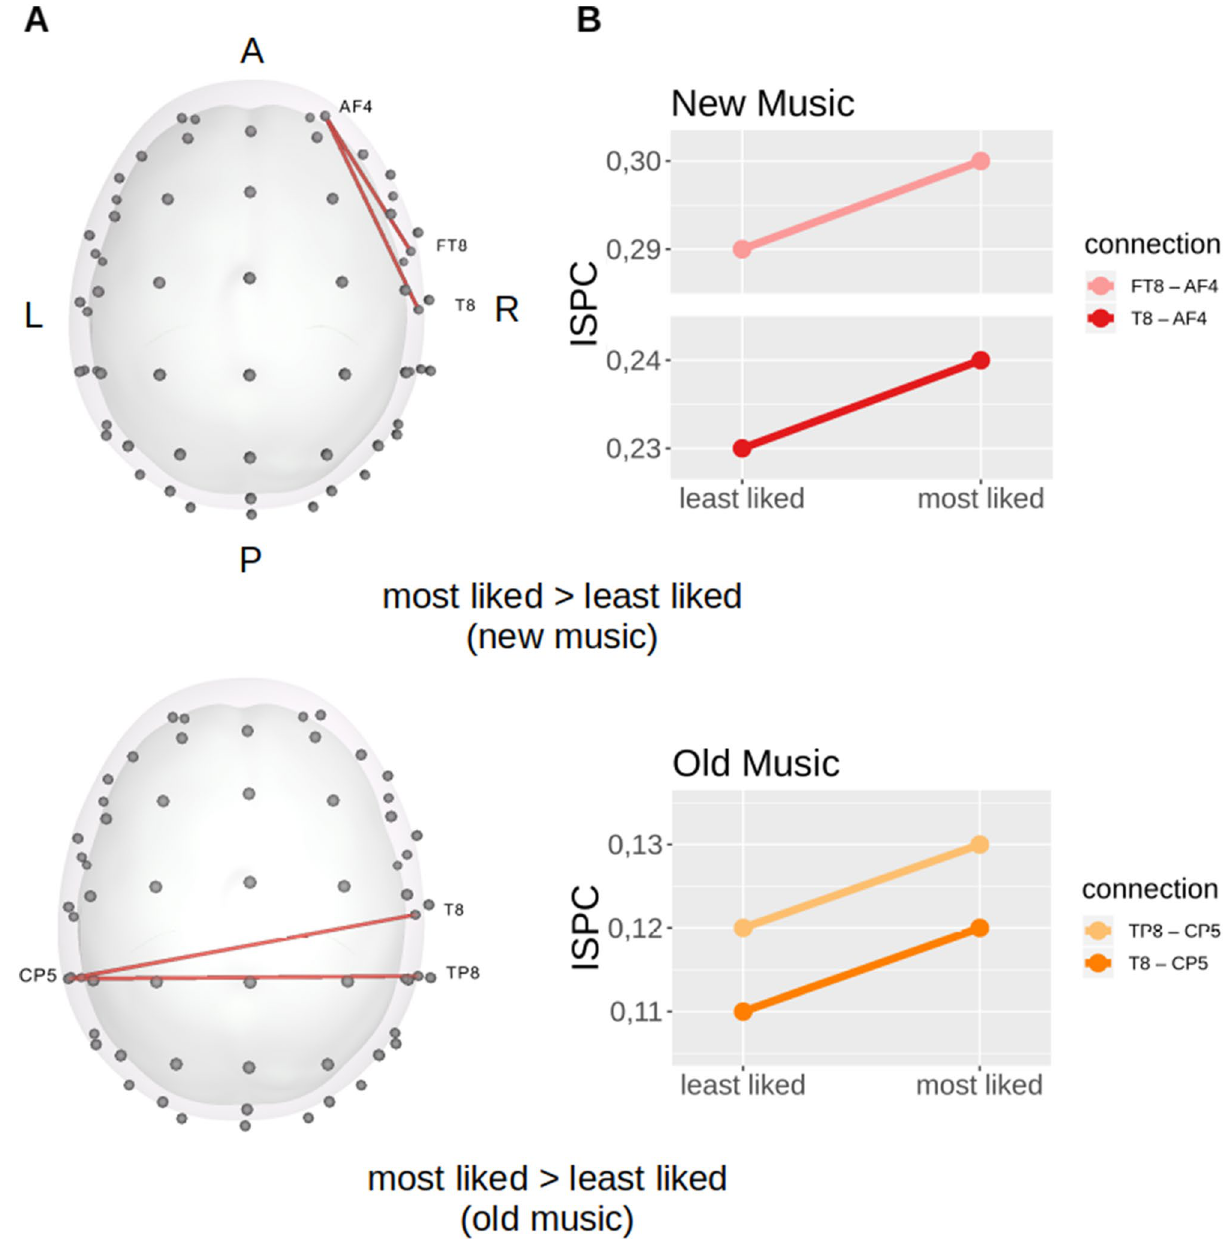
Figure 4. Non-zero results (A) with their corresponding prediction plots (B) in the theta connections of interest. Straight lines represent predictions of the response variables in each pleasantness ⊗ familiarity condition of interest following parameter estimates. Predictions are made on the original scale of the dependent variable. Prediction plots generated in R 53 with package ggplot2 54